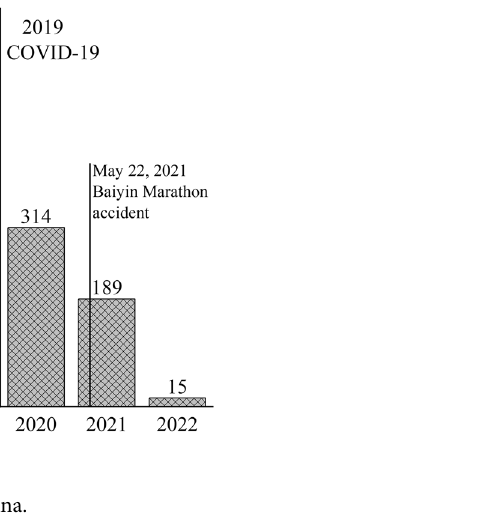
Figure 1. Many marathons held in